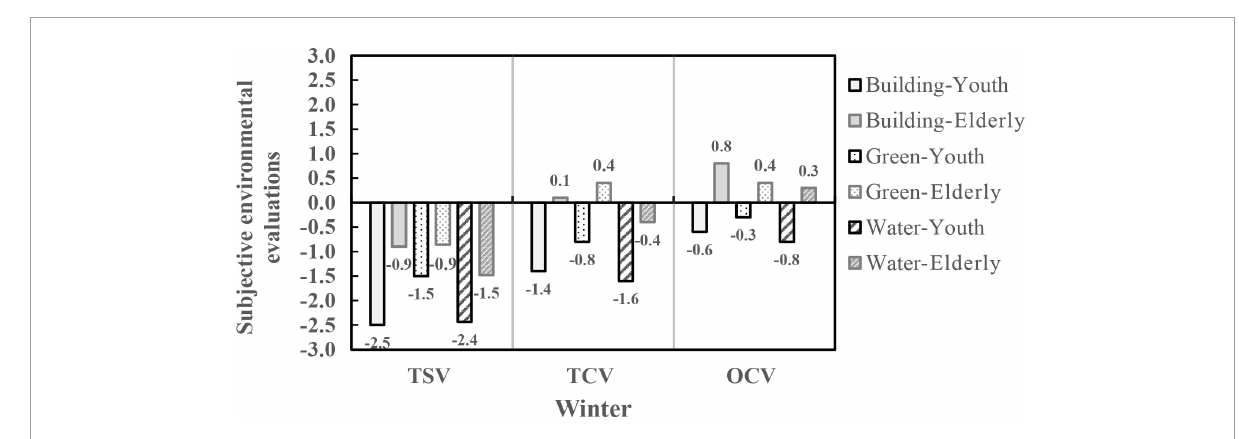
FIGURE7 Subjective environmental evaluations of different age groups in visual landscape